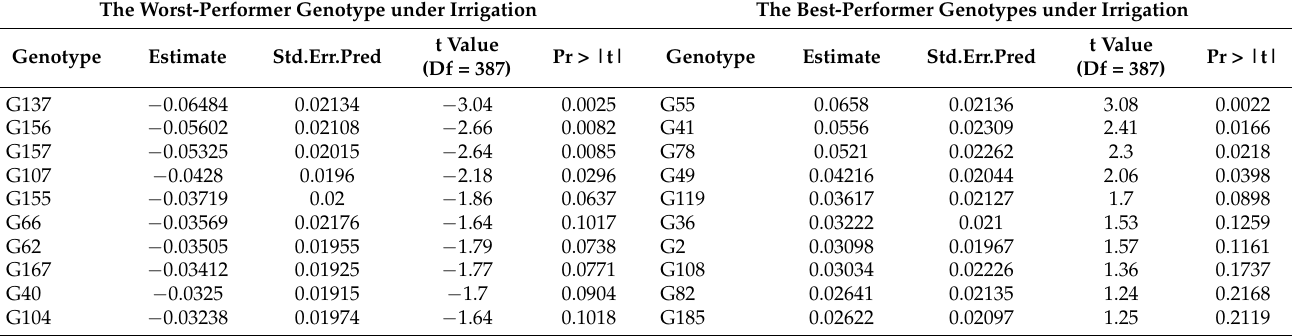
Table 7. The performance of genotypes under irrigation.